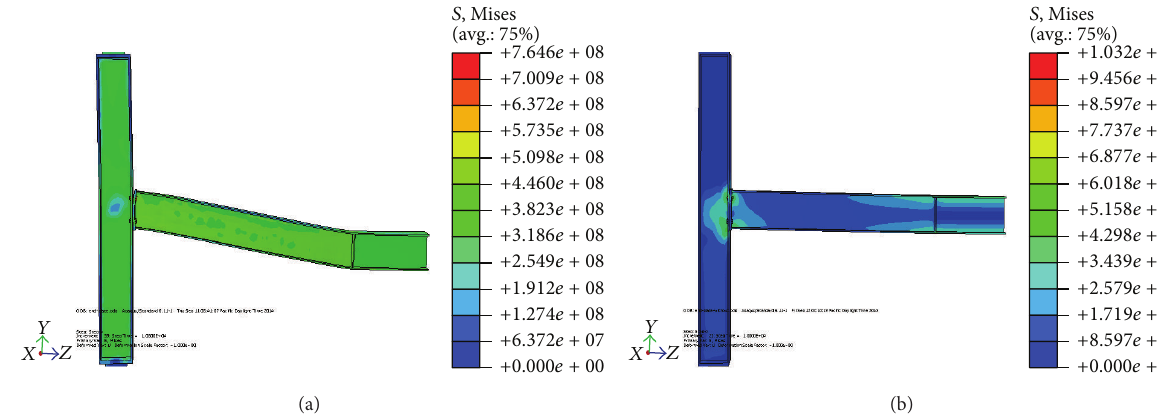
Figure 10: Connection to the end plate: (a) with heat and (b) without